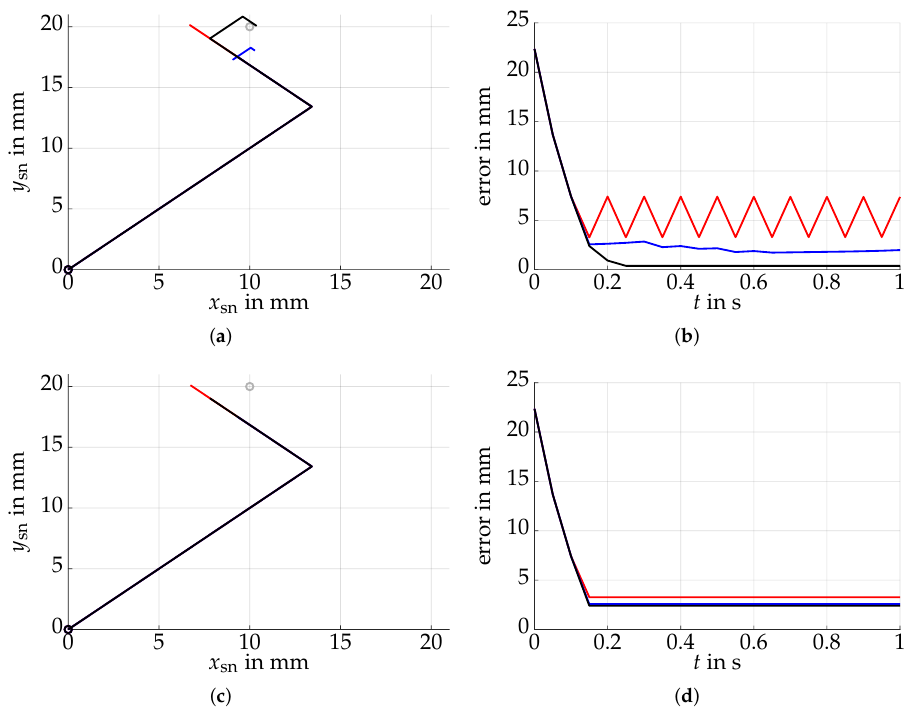
Figure 13. Trajectories (left) from the zero rotation state (black circle) to the reference (gray circle) and the respective errors (right) for the basic (red), extended (blue), and pre-learned extended (black) controllers. The minimum angle Φ min is 0.05° on the top and 0.25° on bottom. ( a ) While the basic controller is not able to achieve a steady state due to a too small Φ min , the extended controllers achieve high accuracies with fewer time steps. ( b ) The quadratic errors confirm the expectation of an oscillating basic controller and show the advantage of the extension. ( c ) If Φ min is larger, the controllers converge to similar solutions. ( d ) A larger minimum angle leads to higher steady state errors, but improves the basic controller due to the missing oscillation. The advantages of the extension do not take